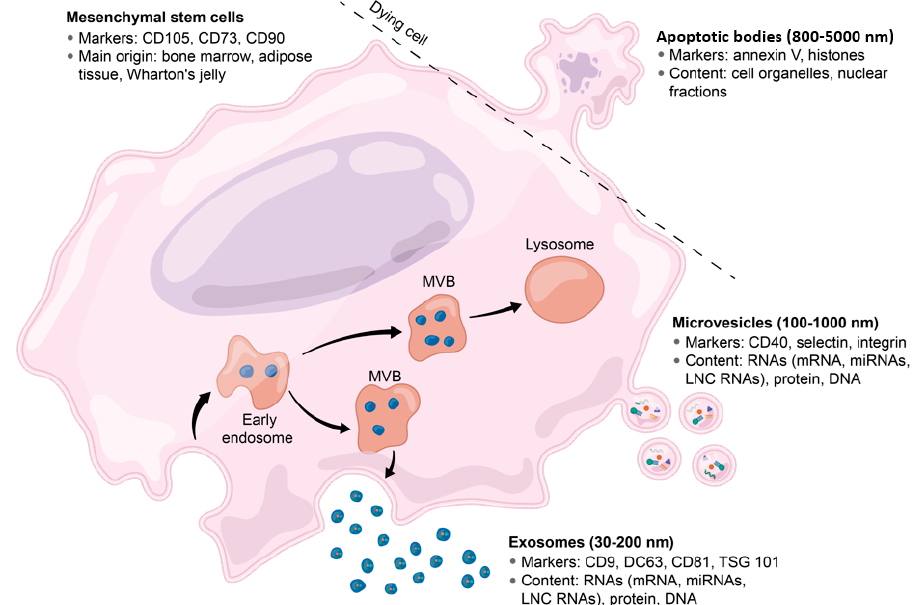
Figure 1. Biogenesis and features of apoptosis bodies (ABs), microvesicles (MVs), and exosomes. Each of the three classes of extracellular vesicle (EV) are characterised by unique biogenesis pathways, molecular markers, and cargo. ABs emerge as the cytoskeleton of apoptotic cells are disassembled and contain various cellular components such as organelles and nuclear fractions. MVs contain a variety of molecular cargo, including DNA, RNA, and protein, and are produced by the cell membrane budding and fission. Exosomes are the smallest class of EV, and are enriched in DNA, RNA, and proteins, and originate from the multivesicular body (MVB).